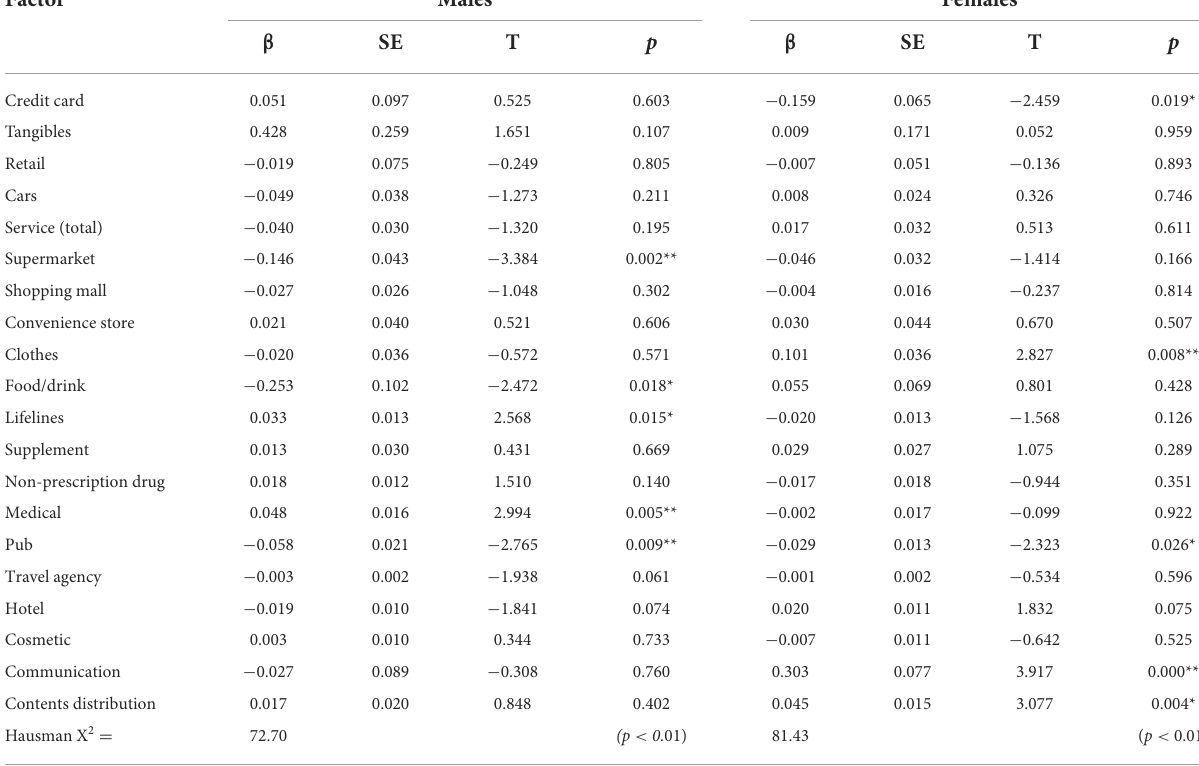
TABLE 4 Relationship between personal consumption expenditures and SDRs for males and females in their twenties in the non-metropolitan region during the COVID-19 pandemic (between March 2020 and December 2021).